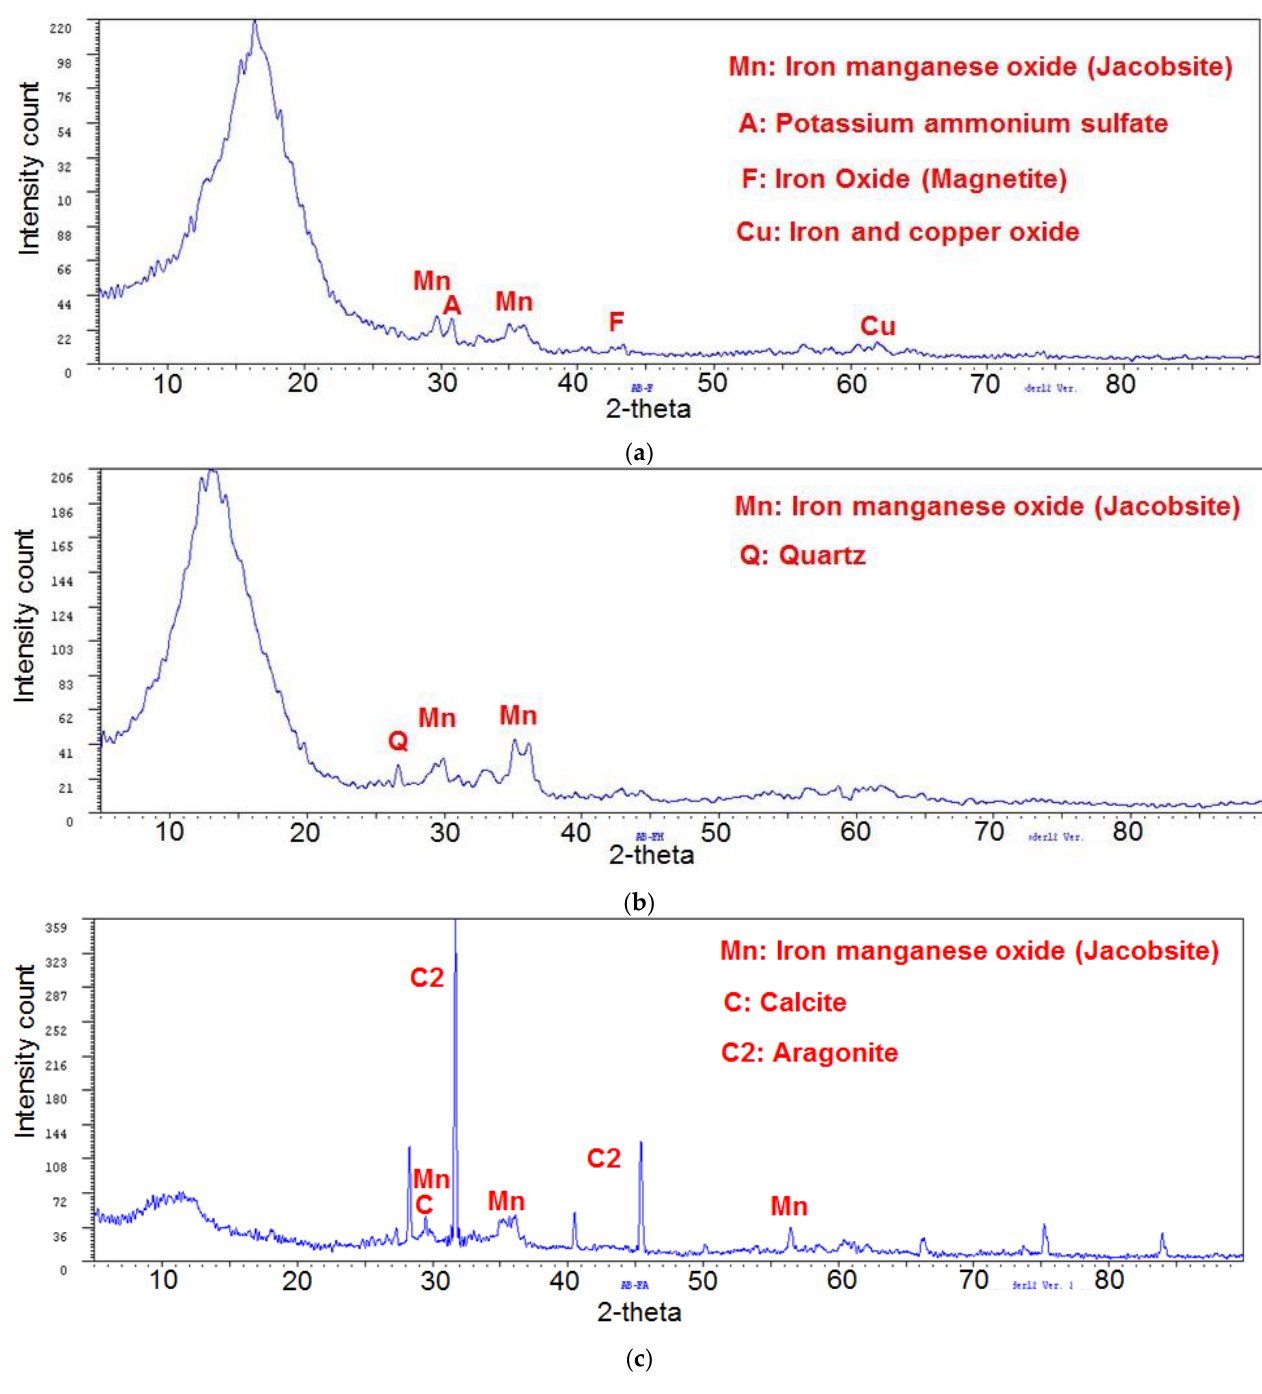
Figure 5. Diffractograms for ferrosilicomanganese fines: ( a ) without modification, ( b ) modified by HCl, ( c ) modified with seawater.